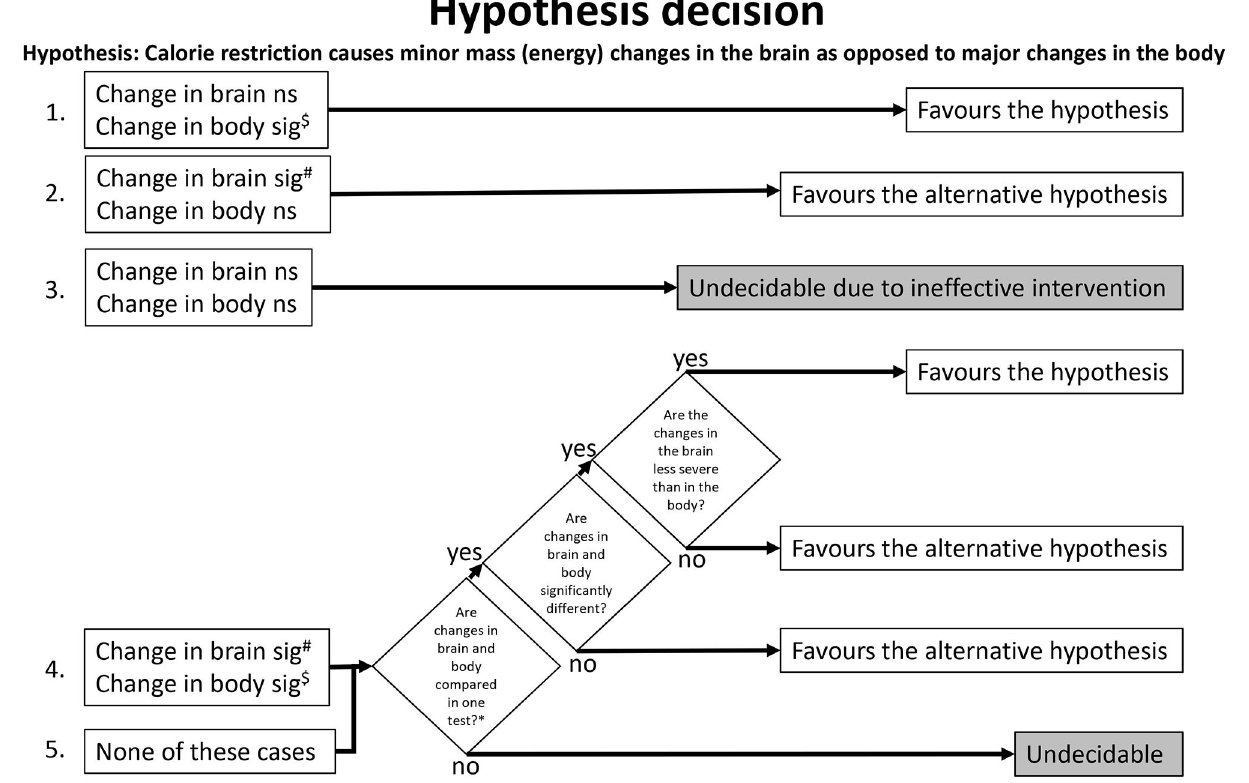
FIGURE 2 | Algorithm for hypothesis decision. The numbers on the left indicate where the algorithm path begins for a given study. $ Overriding exception (unlikely to occur): A significant (sig) increase in the body favors the alternative hypothesis. # Overriding exception (unlikely to occur): A significant increase in the brain favors the hypothesis. *e.g., testing relative brain changes (like change of brain mass/body mass). ns, not significant.